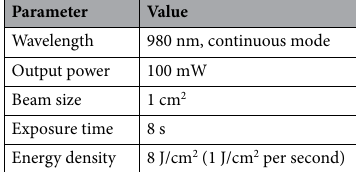
Table 1. Parameters of the employed low-level